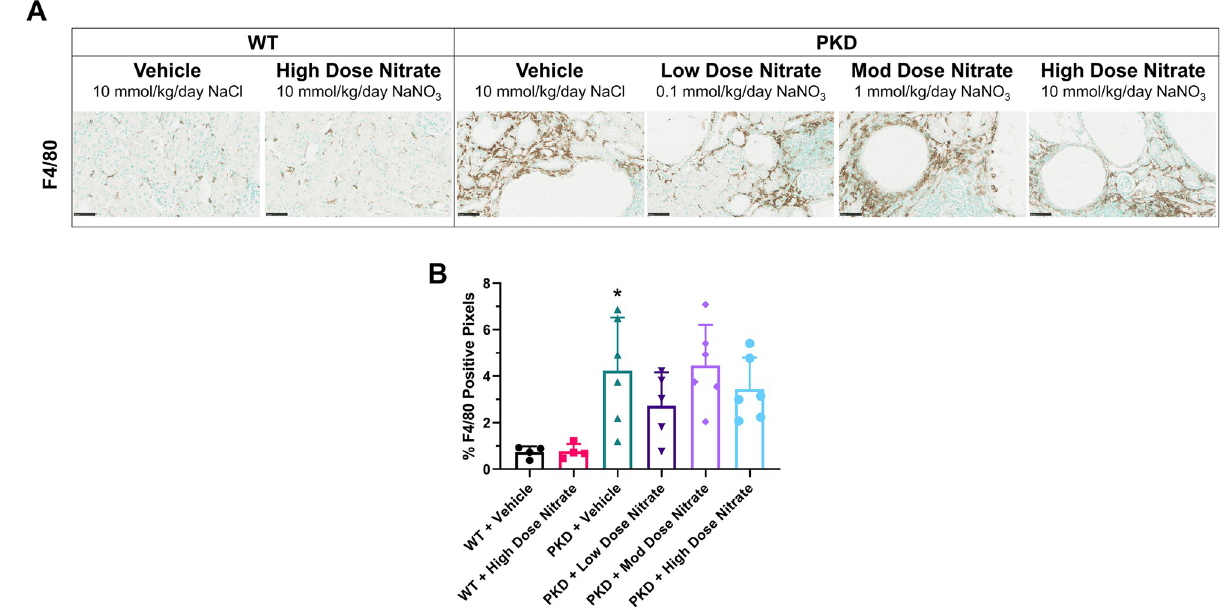
Fig 5. Interstitial inflammation (F4/80) measured by immunohistochemistry, in wild-type (WT) and Pkd1 RC/RC (PKD) mice treated with sodium chloride (vehicle) or sodium nitrate (low, 0.1 mmol/kg/day; moderate, 1 mmol/kg/day; high dose, 10 mmol/kg/day) for 8 months. (A) Representative images of positive F4/80 staining; (B) Quantification of F4/80 positive staining. Data presented as means ± SD (n = 4–6 per group). � P < 0.05 compared to WT + Vehicle by independent t-test.